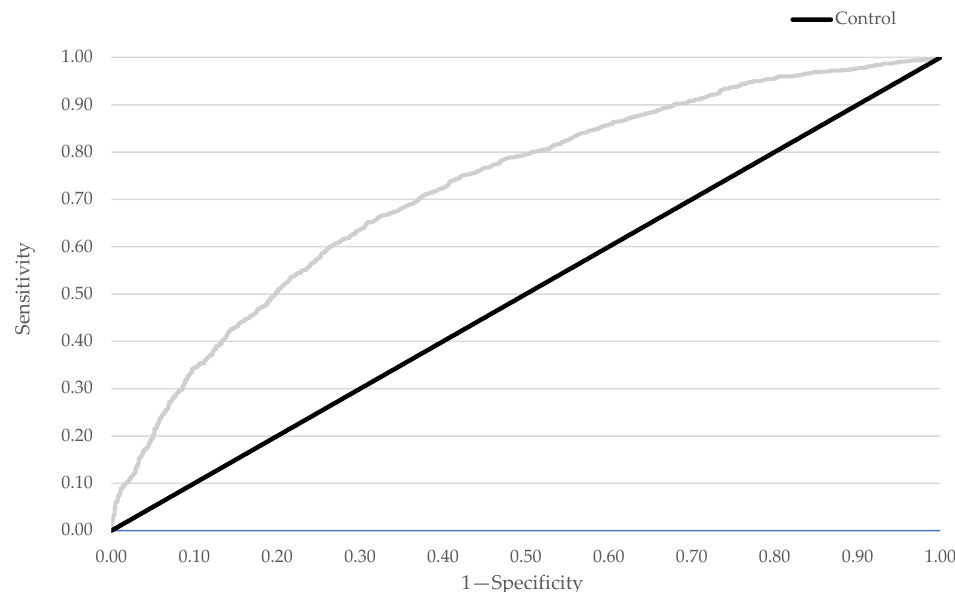
Figure 5. Receiving operating characteristic (ROC) curves for the C-reactive protein predictive model.